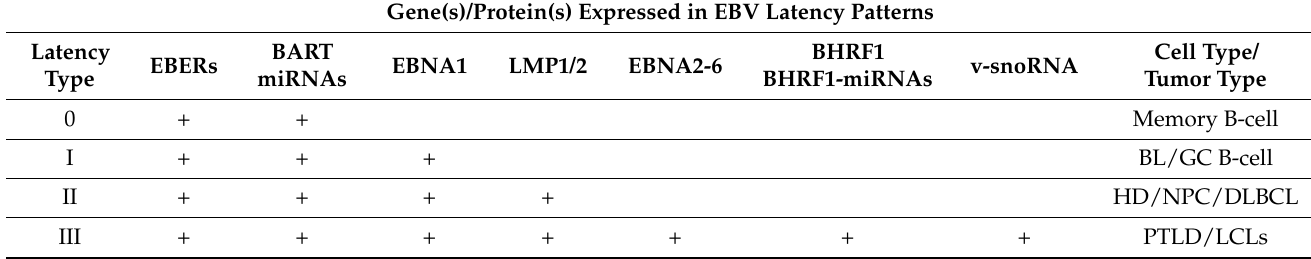
Table 1. Latency type and expression of EBV